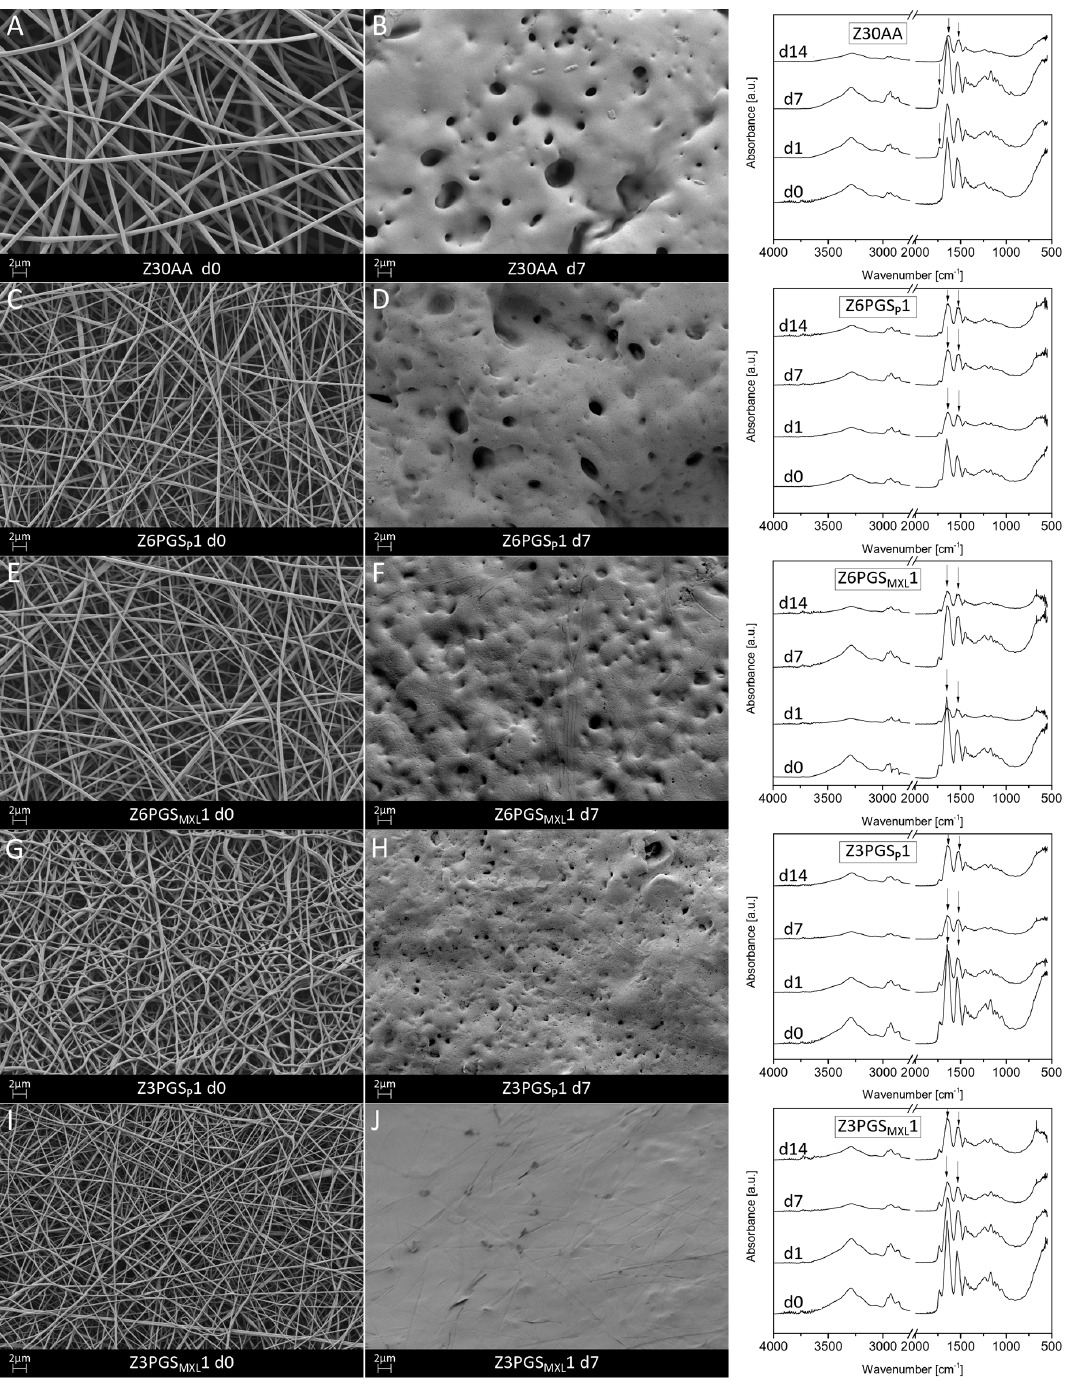
Figure 6. SEM micrographs of Z30AA ( A , B ), Z6PGS P 1 ( C , D ), Z6PGS MXL 1 ( E , F ), Z3PGS P 1 ( G , H ) and Z3PGS MXL 1 ( I , J ) before and after 7 days of degradation at 5000× magnification and respective FTIR spectra (the peaks in the FTIR spectra are discussed in the text).